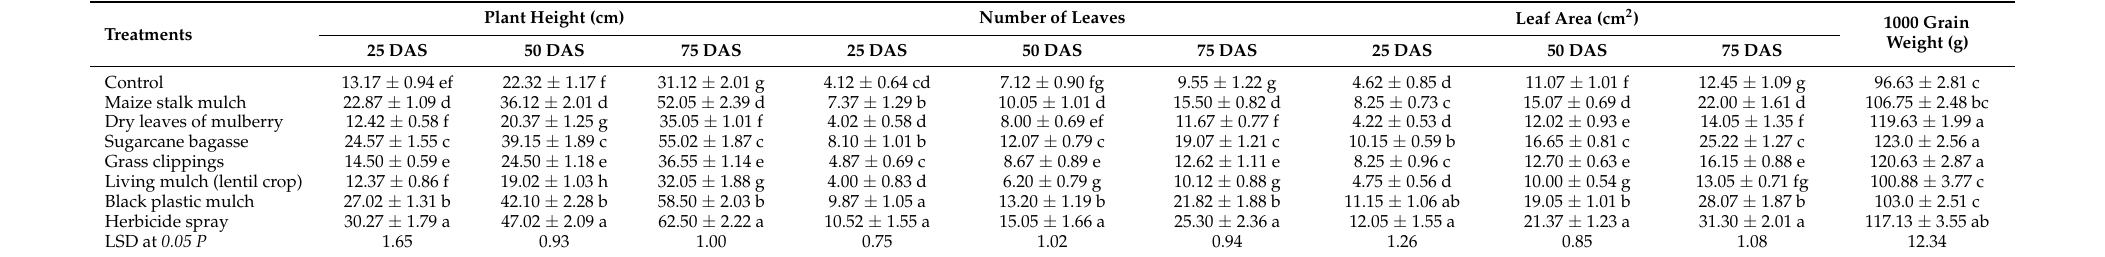
Table 5. Effect of various mulch materials on growth and yield of